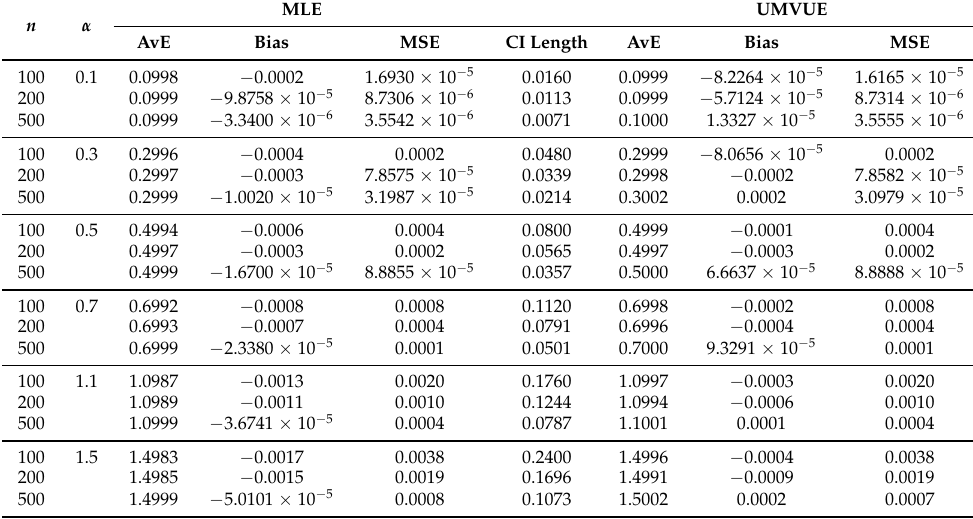
Table 1. AvE, bias, MSE and 95% CI length (only for MLE) for the proposed estimators (MLE and UMVUE) of the single parameter ( α ) of the AU distribution, considering different sample sizes ( n